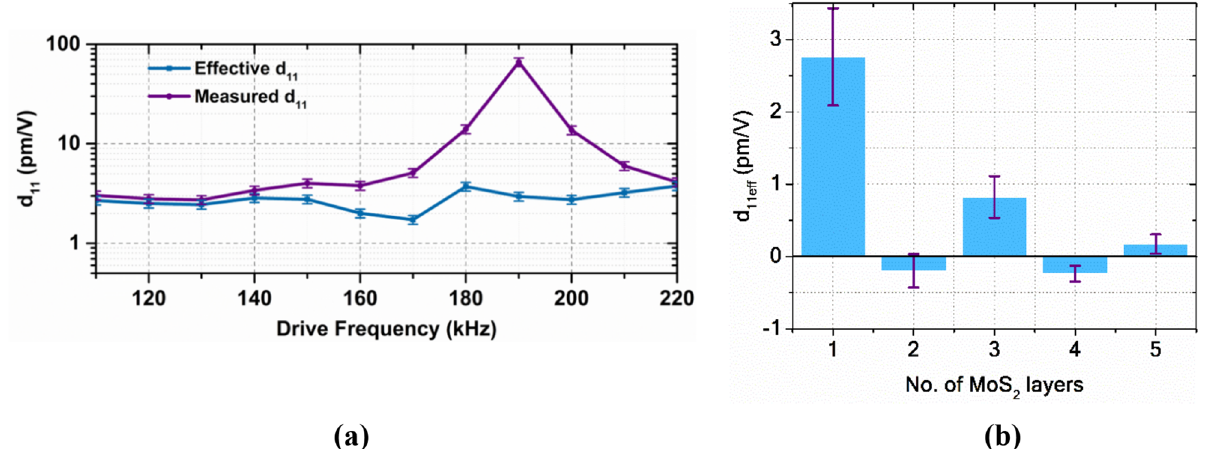
Figure 5. ( a ) The effective and measured d 11 coefficients measured at different frequencies for a monolayer MoS 2 near the contact resonance frequency range (here the gain in the signal by operating at a frequency within resonance bandwidth is normalized for effective piezoelectric coefficients), ( b ) d 11 coefficients of MoS 2 from monolayer to